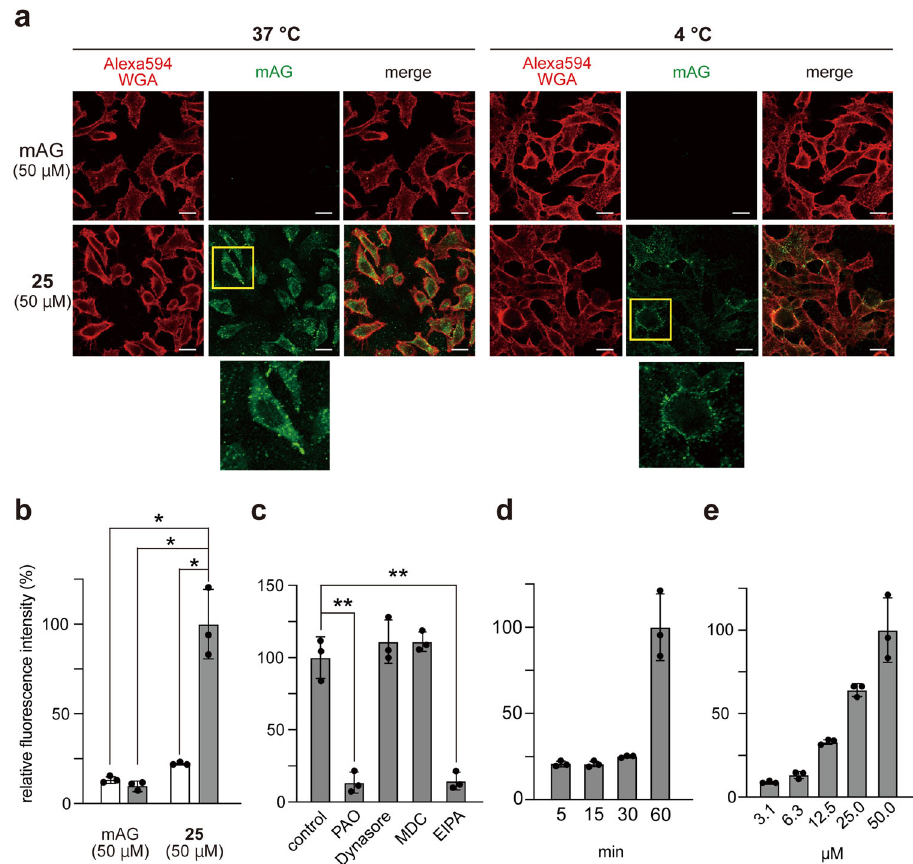
Fig. 8 Cytosolic deliveries of mAG conjugated with ε -O β L. a Cytosolic deliveries of mAG conjugated with ε -O β L ( 2 ). HeLa cells were incubated with mAG and ε -O β L-mAG ( 25 ) for 60 min at 37 °C and 4 °C. The cellular localization of 25 (green) was determined by CM after washing and fi xing the cells. The cell membrane was stained with Alexa594-WGA (red). The representative CM images and the magni fi ed views of the yellow-boxed areas are shown. Scale bars, 20 µ m. b – e Relative cellular uptakes of 25 into HeLa cells. HeLa cells were incubated with 50 µ M (unless otherwise noted) of mAG or 25 . mAG and 25 were incubated with cells for 60 min at 37 °C (light gray) and 4 °C (white) ( b ). The results are presented as the mean ± s.d. ( n = 3). *Signi fi cant at p < 0.05 by two-way ANOVA followed by Sidak ’ s multiple comparisons test. Protein 25 was incubated with cells for 60 min at 37 °C in the culture medium supplemented with an endocytosis/macropinocytosis inhibitor (PAO, Dynasore, MDC, or EIPA) ( c ). The results are presented as the mean ± s.d. ( n = 3). **Signi fi cant at p < 0.01 by one-way ANOVA followed by Tukey ’ s multiple comparisons test. Protein 25 was incubated with cells for 5 – 60 min at 37 °C ( d ), and 25 (3.1 – 50 µ M) was incubated with cells for 60 min at 37 °C ( e